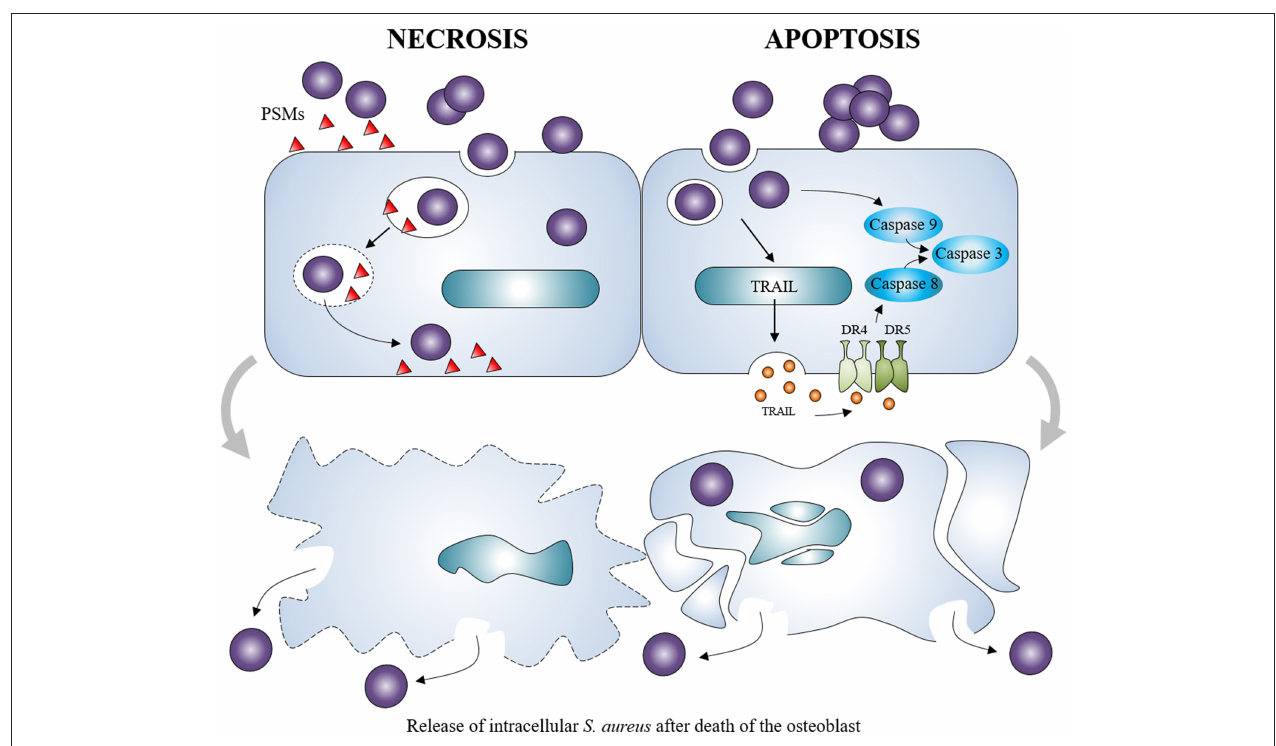
FIGURE 4 | Staphylococcus aureus induction of osteoblast death. Staphylococcus aureus can cause the necrosis of osteoblasts through the release of membrane-damaging virulence factors such as PSMs. It can also induce the apoptosis of osteoblasts through intrinsic and extrinsic caspase pathways. Both can lead to the release of intracellular Staphylococcus aureus, which can re-infect other osteoblasts.